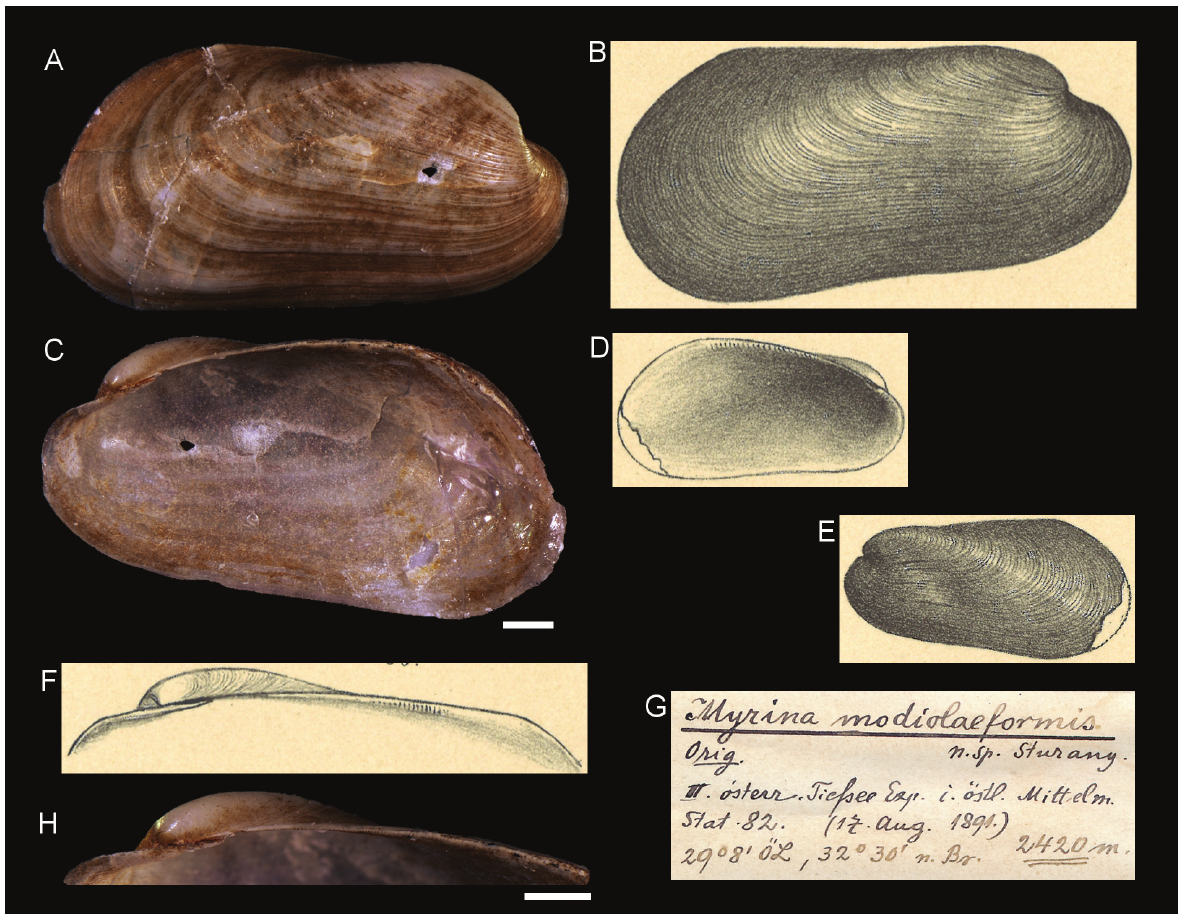
Figure 10. Myrina modiolaeformis Sturany, 1896, station 82, north of Alexandria, Egypt, 2420 m. A , C , H . Syntype NHMW 13011a: outer ( A ) and inner ( C ) view, hinge ( H ). B , D – F . Original figures in Sturany, 1896. G . Original label. Scale bars: 1